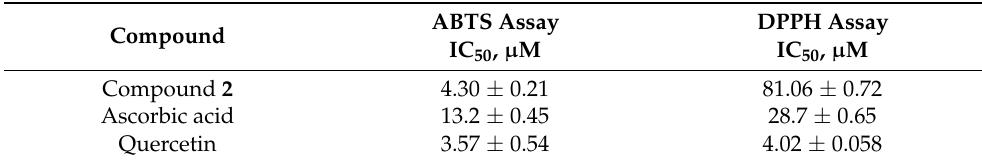
Table 5. Antioxidant activity of compound 2 in comparison with ascorbic acid and